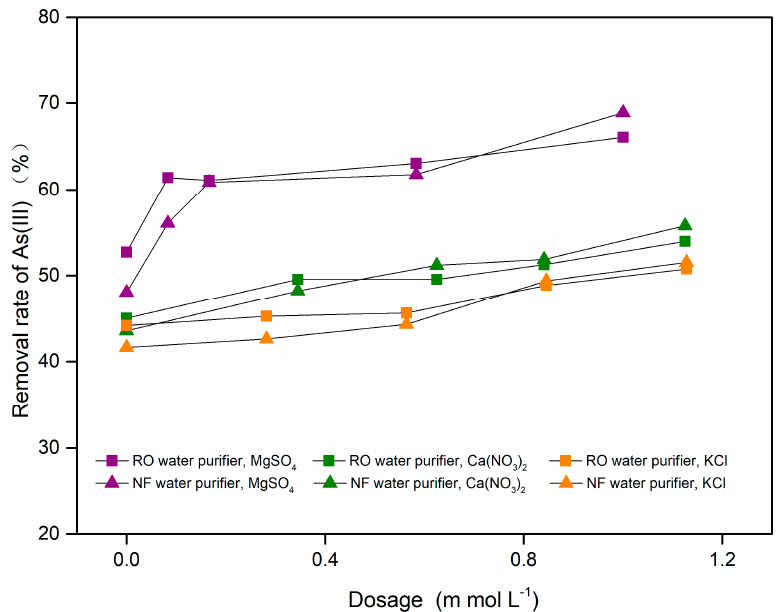
Figure 8. Effect of inorganic salt on the removal efficiency of As(III). The X -axis represents the molar concentration of the added salts (MgSO 4 , Ca(NO 3 ) 2 , KCl).